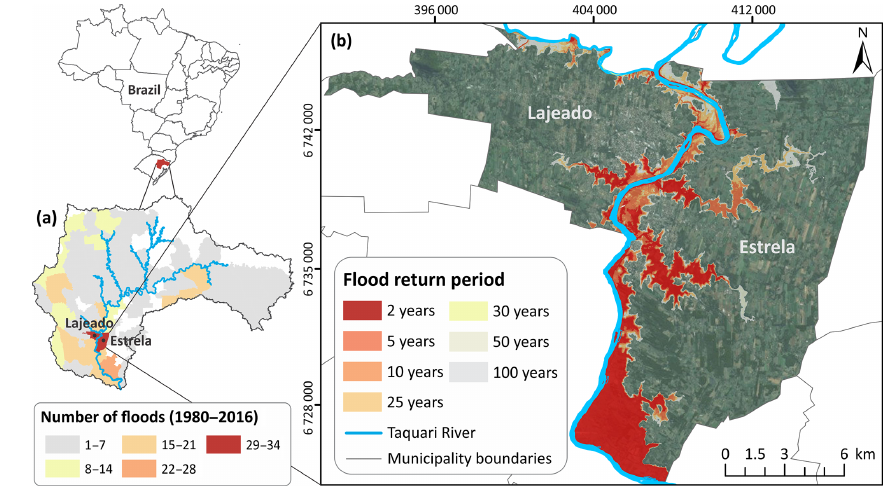
Figure 1. Location of the study area, southern Brazil: (a) number of floods between 1980 and 2016 in the Taquari-Antas River Basin (elaborated based on Bombassaro and Robaina, 2010; MI, 2017); (b) extent of floods with different return periods in the municipalities of Lajeado and Estrela (Fadel,